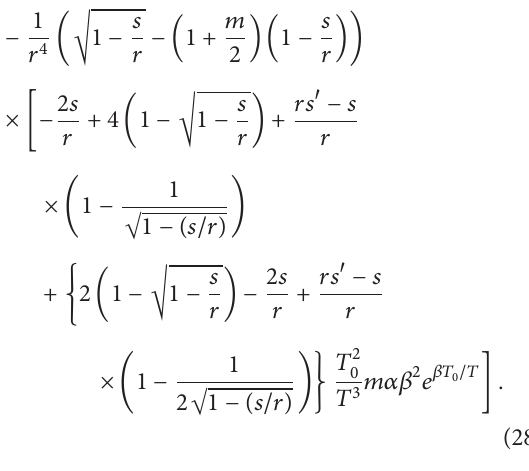
Figure 3 represents the graph of these expressions versus 𝑟 which indicate that 𝜌 and 𝜌+𝑝 𝑡 show decreasing behavior but remain positive while behavior of 𝜌+𝑝 𝑟 is negative. Thus, the WEC is violated for wormhole solution in the galactic halo